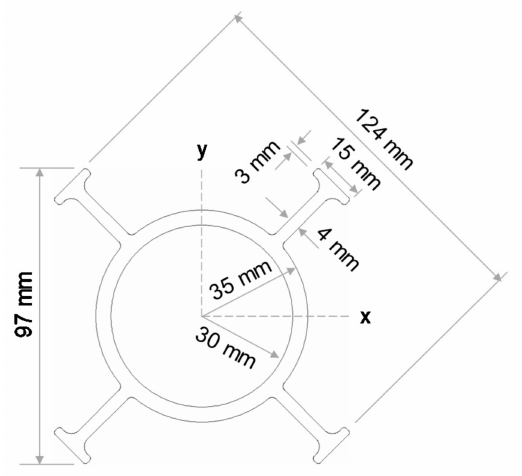
Figure 2. Dimensions of FRP tube with external flanges.